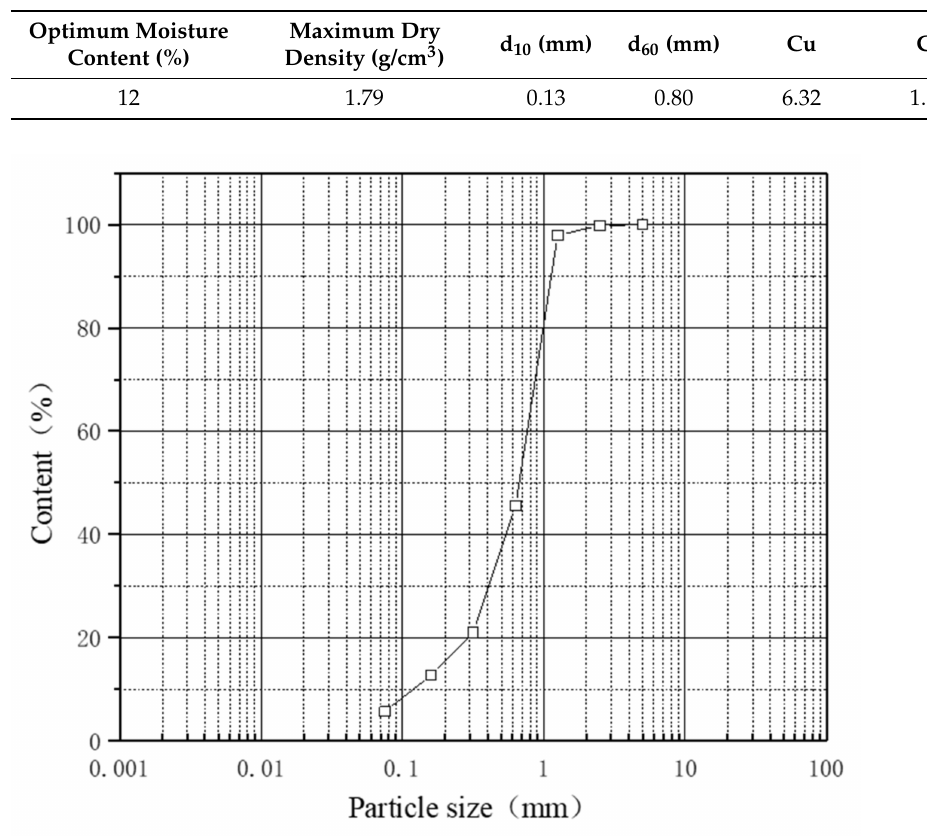
Table 1. Basic physical properties of coarse-grained soils for the test.